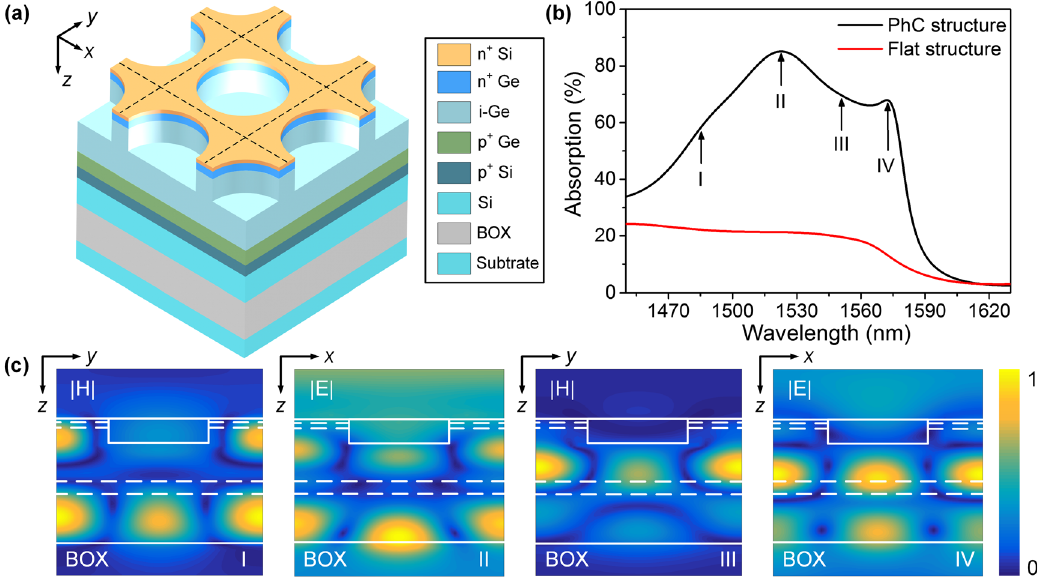
Figure 2: FDTD simulation of resonant PhC. (a) One unit cell of the periodic hole (the square denoted by the dashed line). (b) Calculated absorption spectra of the PhC and flat structure. Period, hole diameter and etching depth are 540, 300 and 215 nm, respectively. (c) The normalized electric (mode II and IV) and magnetic (modeI andIII) fi eldintensitydistributionsofthefourGMRsalongcrosssectionsinthe x-z and y - z planes.DashedlinesindicatethedopedGe